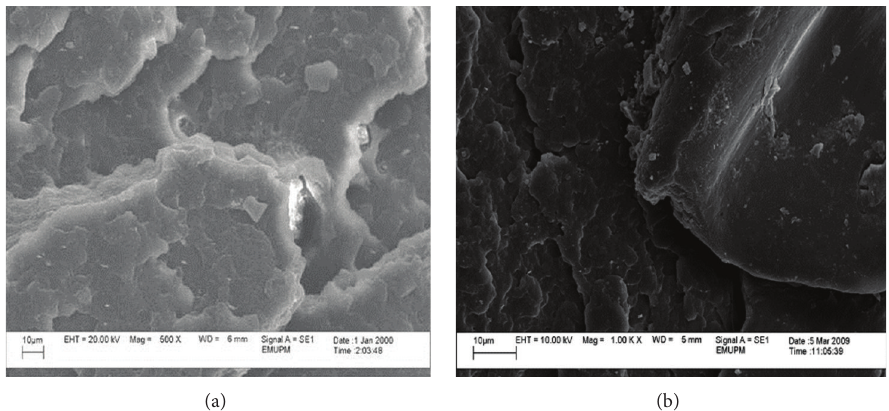
Figure 10: SEM micrograph of the fractured surface of PP/3% nano 𝛼 -Al 2 O 3 composites (a) in the presence of dispersant and (b) in the absence of dispersant.